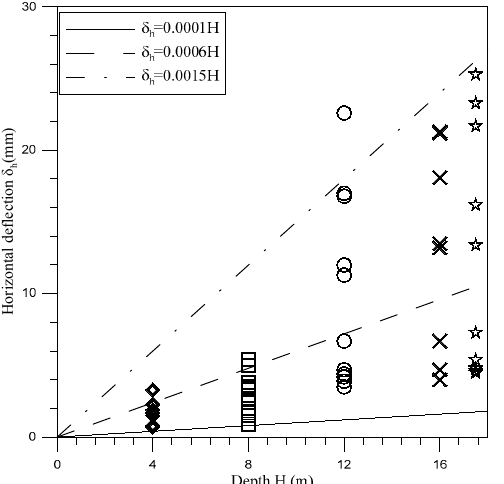
Figure 18. Deflection of retaining wall versus excavation depth (nodes 12–22).